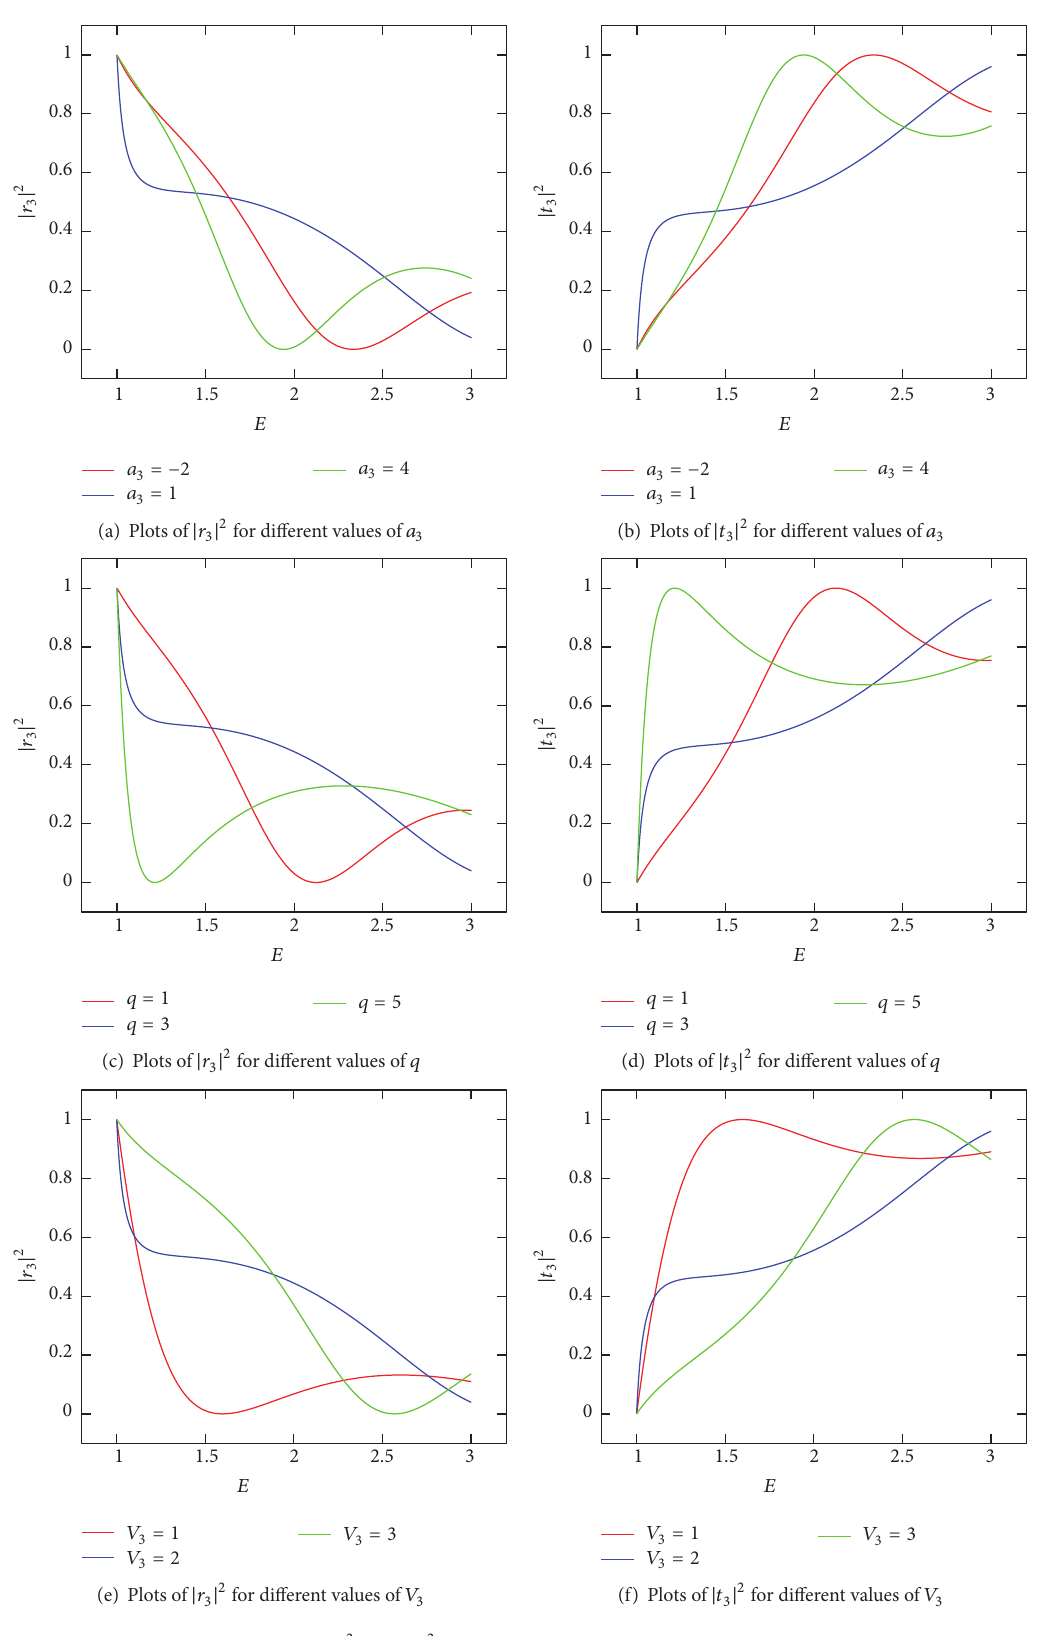
(f) Plots of |𝑡 3 | 2 for different values of 𝑉 3 Figure 6: In this figure, different treatments of |𝑡 3 | 2 and |𝑟 3 | 2 as parameters 𝑎 3 , 𝑞 , and 𝑉 3 vary have been plotted. We set the parameters in (a) and (b) 𝑉 3 = 2 , 𝑞 = 3 , (c) and (d) 𝑉 3 = 2 , 𝑎 3 = 1 , and (e) and (f) 𝑞 = 3 , 𝑎 3 = 1